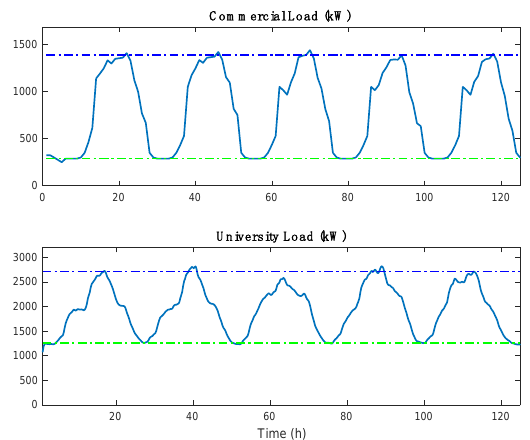
Figure 2. Average commercial hourly load (top graph) and Santa Clara University hourly power usage (bottom graph) over a five-day period (green and blue dashed lines represent the minimum and maximum power demand for the load, respectively).